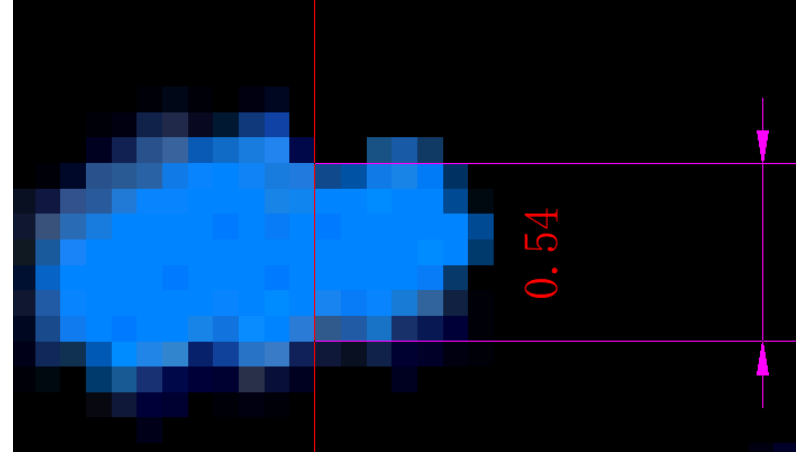
Figure 9. Schematic diagram of the marking the length of coarse aggregate.